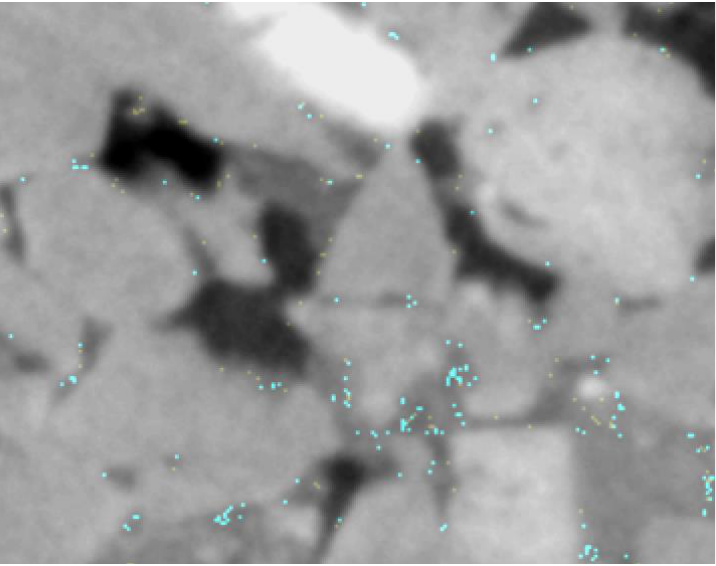
Figure 3. Raw image with a superposed representation of “additional” pore space voxels in cyan of a raw image and “missing” pore space with an Ilastik segmentation compared to when prefiltered with Anisotropic Diffusion and Ilastik segmentation.